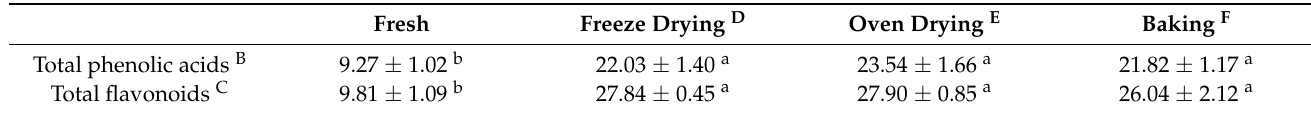
Table 3. Effect of different drying methods on the contents of total phenolic acids and total flavonoids in C. osmophloeum leaves A .